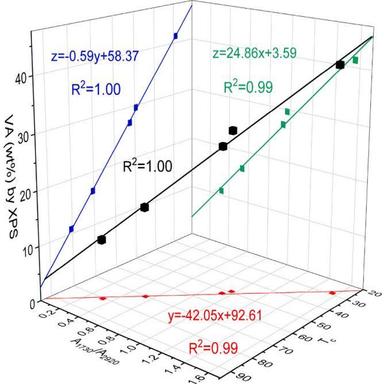
Relationships between the VA content measured by XPS, the IR-ATR absorption ratio of the C––O band at 1730 cm− 1 and the CH2 band at 2920 cm− 1 determined by FTIR, and the DSC crystallization peak temperature Tc.